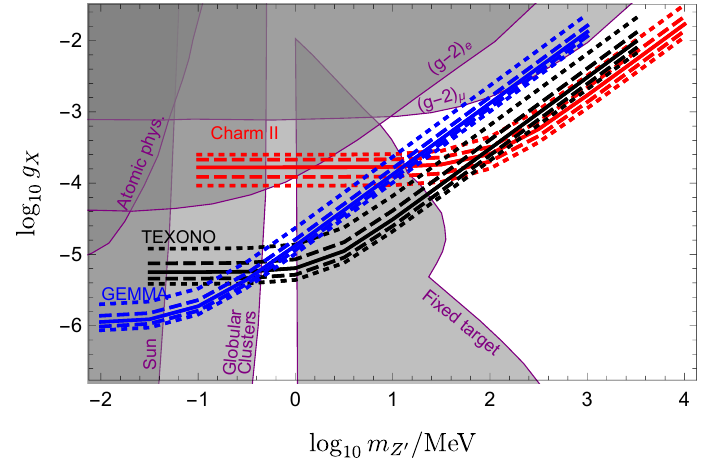
Figure 1 . Constraints on g X when (cid:11) = (cid:15) = 0. The U(1) X charges of e R and ‘ L = ( (cid:23) e ; e ) T listed to the right of the plot, taken from table 1.